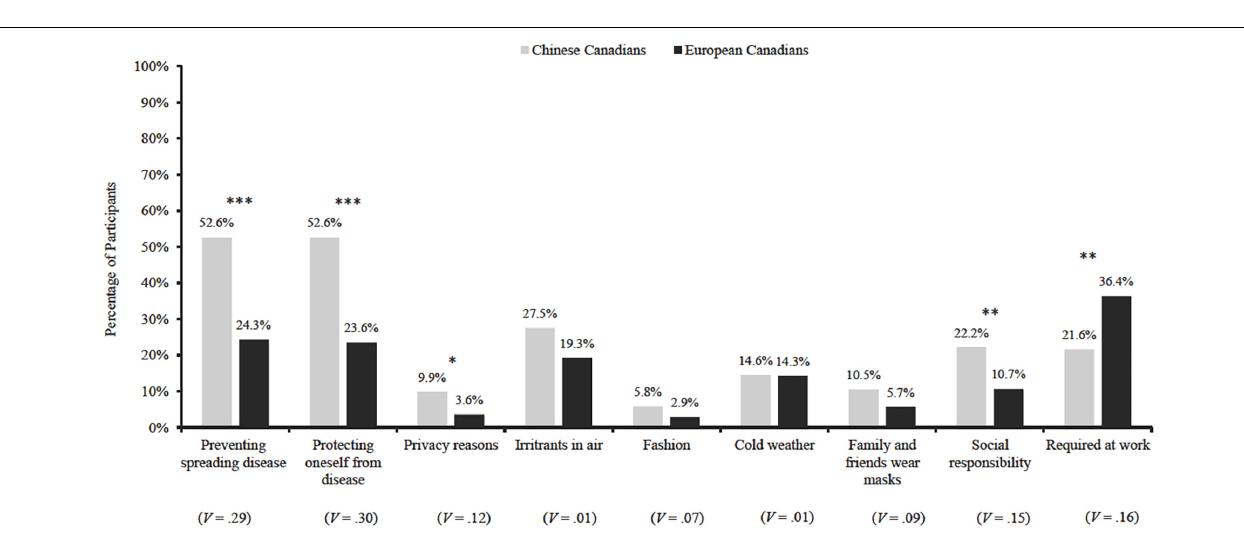
FIGURE 2 | Mask-wearing reasons among Chinese Canadians ( n = 171) and European Canadians ( n = 140) before the COVID-19 pandemic. ∗ p < 0.05, ∗∗ p < 0.01, ∗∗∗ P < 0.001, V , Cramer’s V